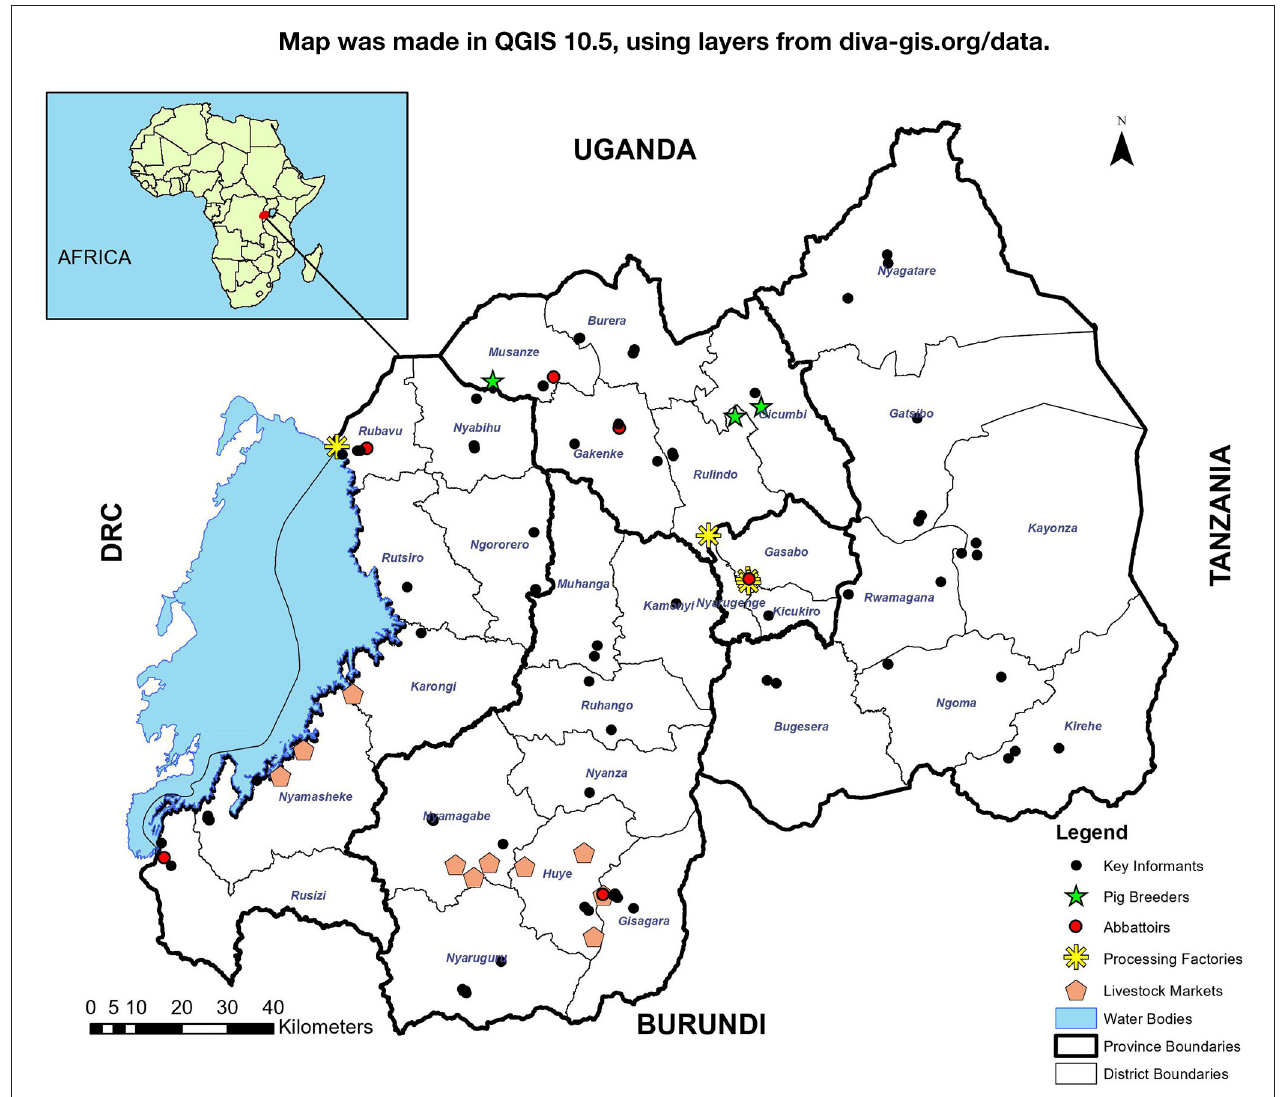
FIGURE 1 | Map of Rwanda with administrative boundaries showing the various study